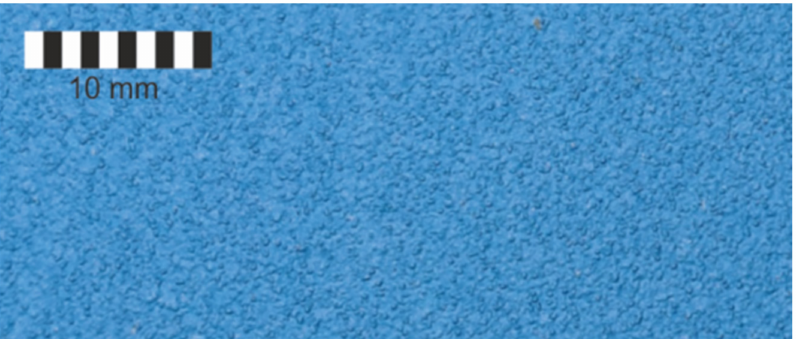
Figure 9. Image of the rough structure of the paint coating affecting the range of thickness measured by the electromagnetic method.